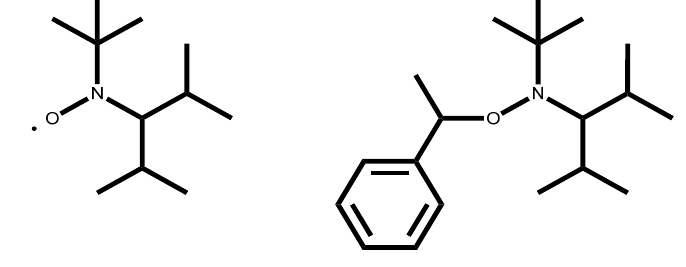
Figure 3. Structure of nitroxide BIPNO (N) and the corresponding alkoxyamine PhEt-BIPNO